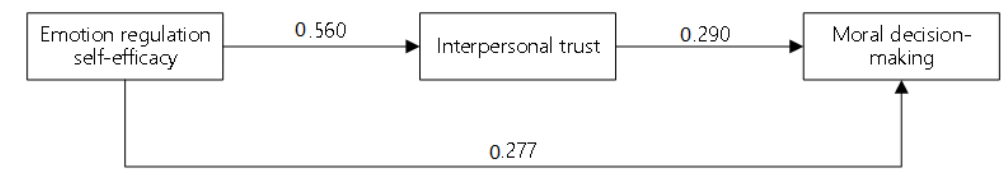
Figure 4. The mediating role of interpersonal trust between emotional regulation self-efficacy and moral decision-making.